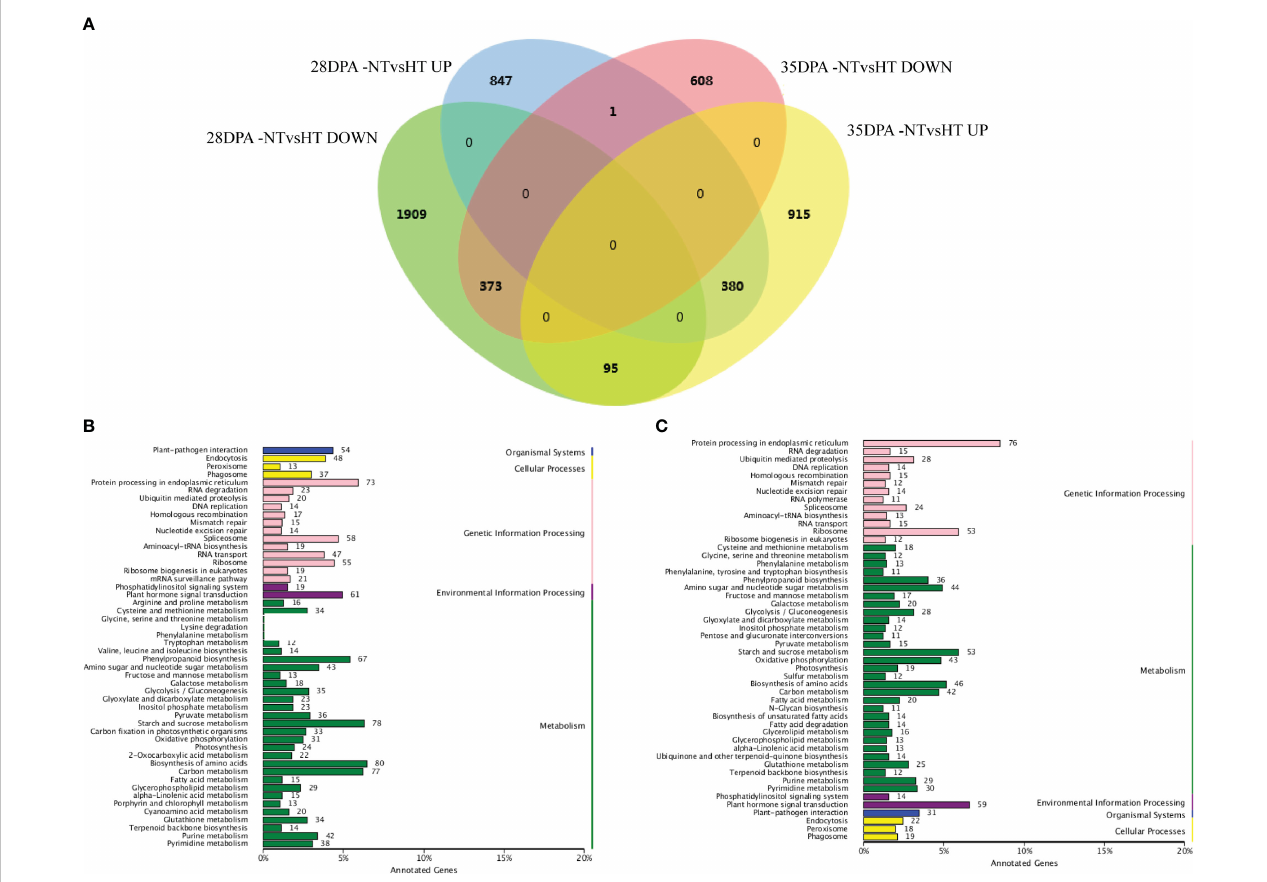
FIGURE 1 Differentially expressed mRNAs and KEGG analysis. (A) Venn diagram of differentially expressed mRNAs. (B) The KEGG analysis of differentially expressed mRNAs identi fi ed in 28DPA-NTvsHT. (C) The KEGG analysis of differentially expressed mRNAs identi fi ed in